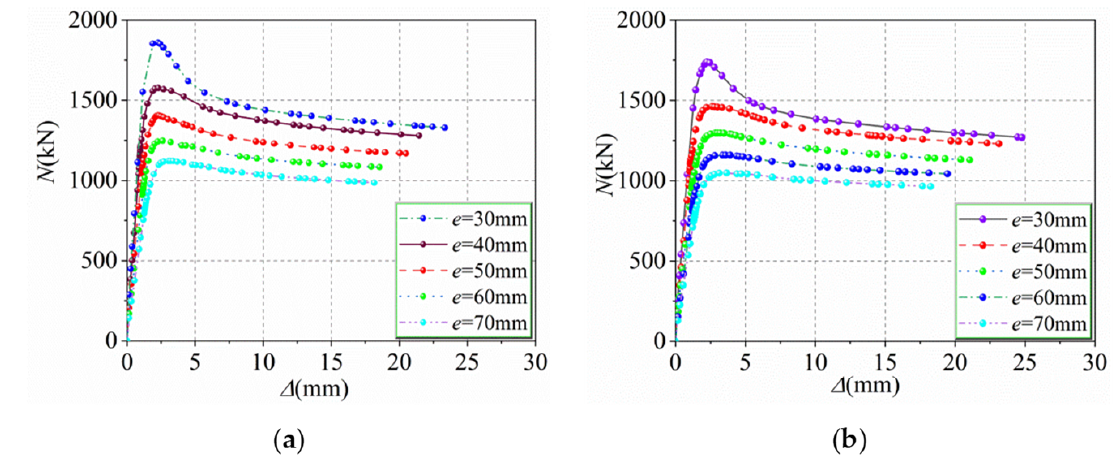
Figure 8. Curves of load–deflection for specimens with various e : ( a ) f cu = 120 MPa; ( b ) f cu = 100 MPa.